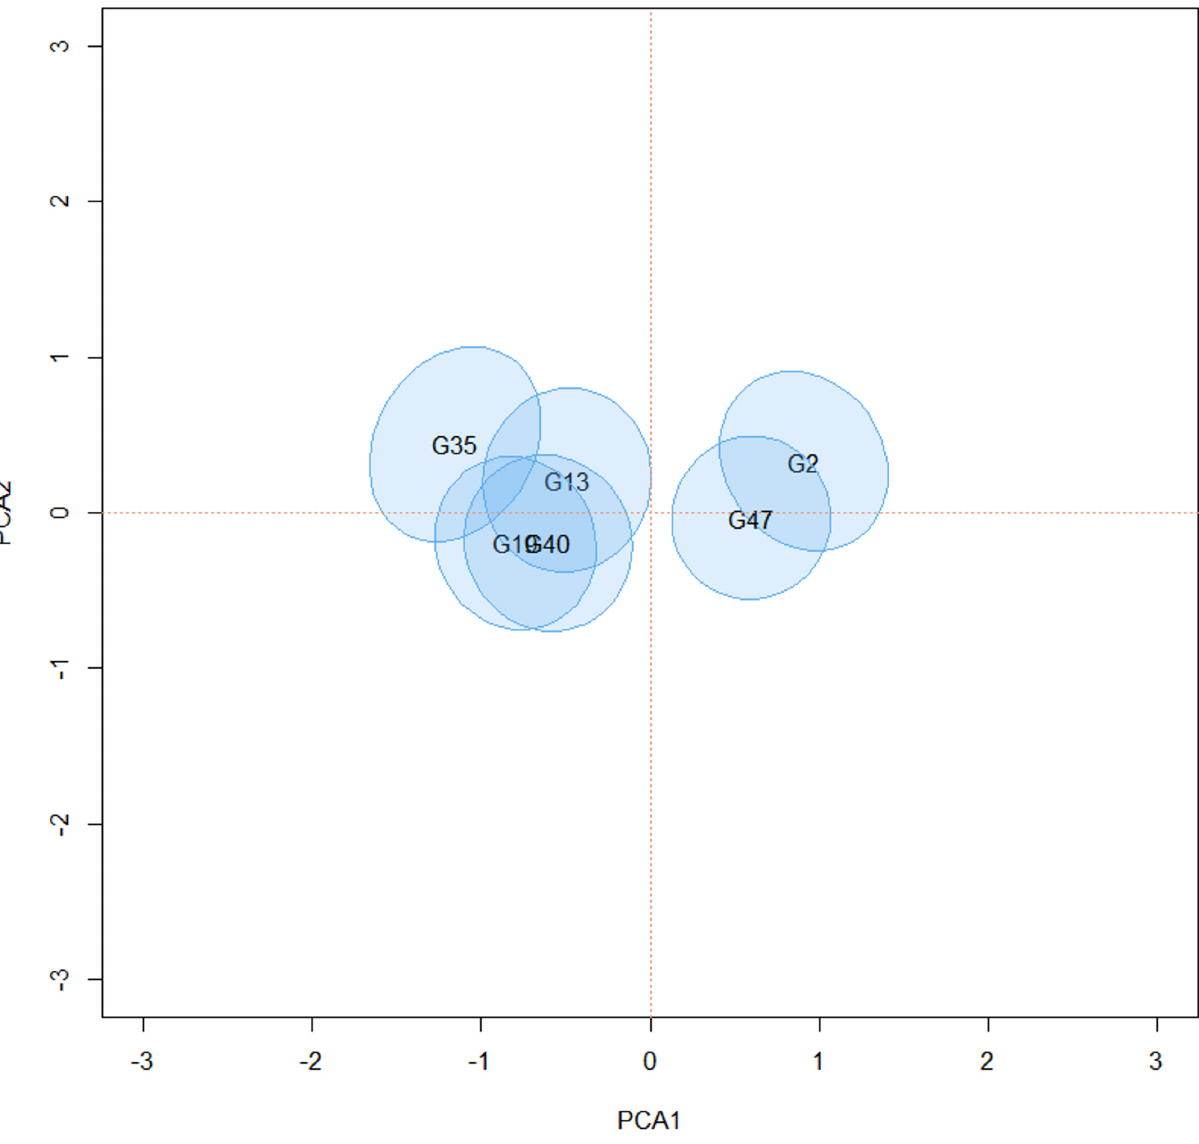
Fig 10. 95% credible regions that do not include the origin for the first two principal axes of the genotype scores using the AMMIB